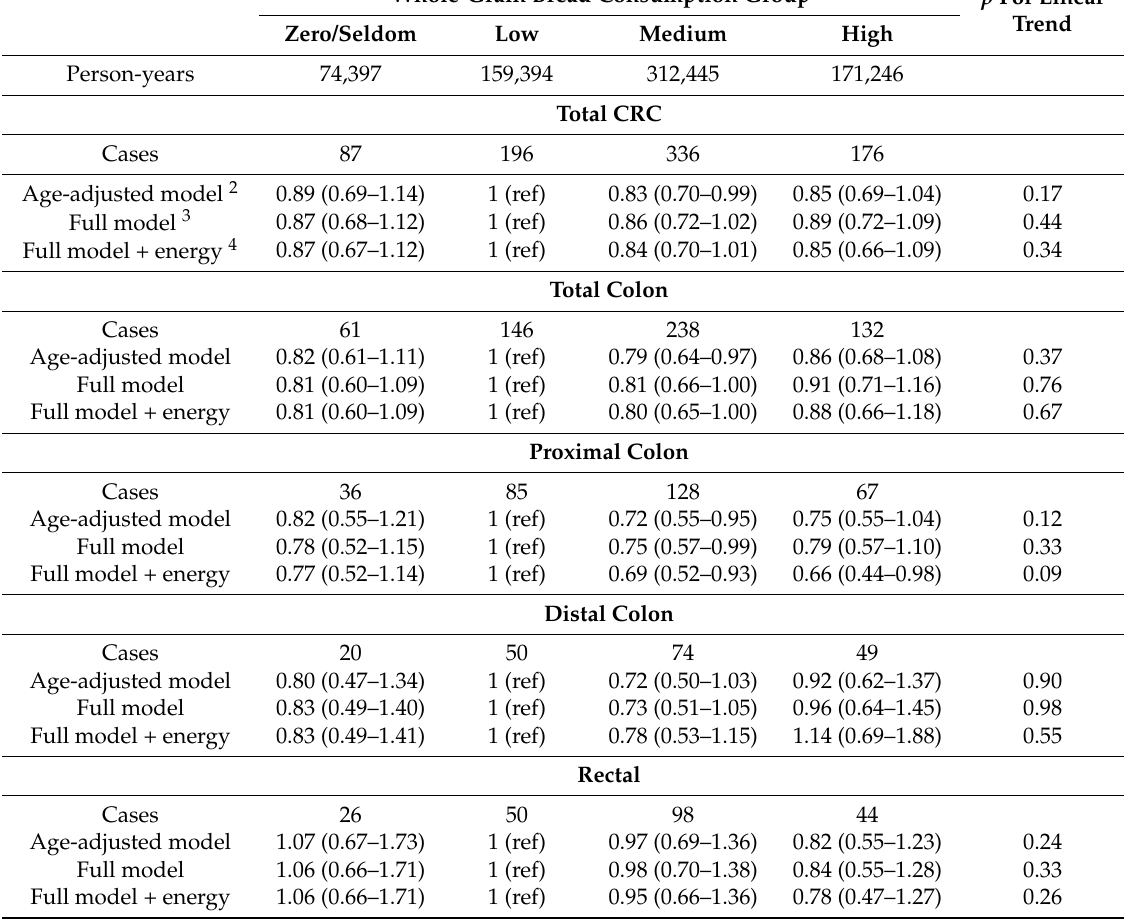
Table 3. Hazard ratios and 95% confidence intervals for the risk of total colorectal cancer (CRC) and colorectal subsites according to whole-grain bread consumption in the Norwegian Women and Cancer Study, n =